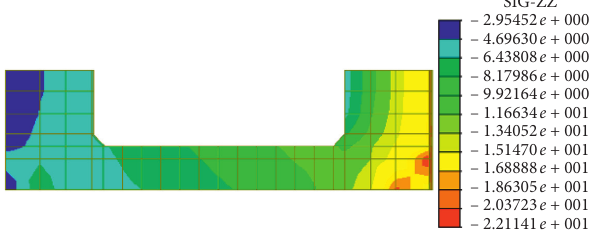
Figure 9: Normal stress of bevel section (MPa).